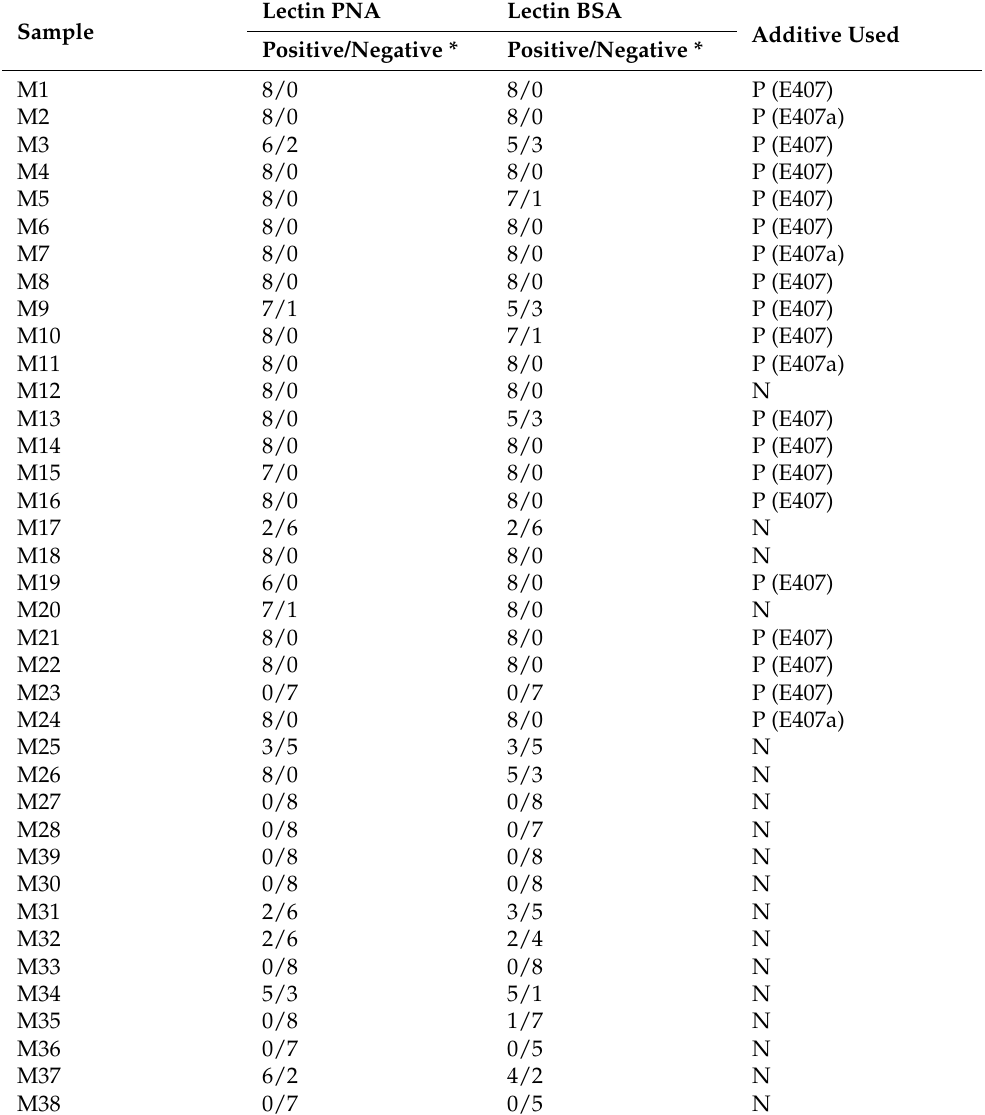
Table 6. Results of lectin histochemistry in meat product samples from the market